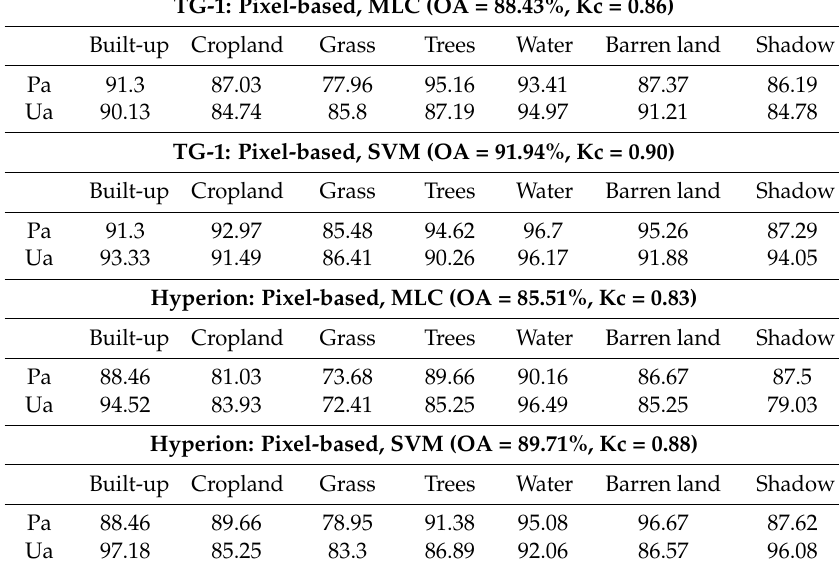
Table 4. Confusion matrices and associated pixel-based classifier accuracy with the best OA in regard to sensors of TG-1 and Hyperion